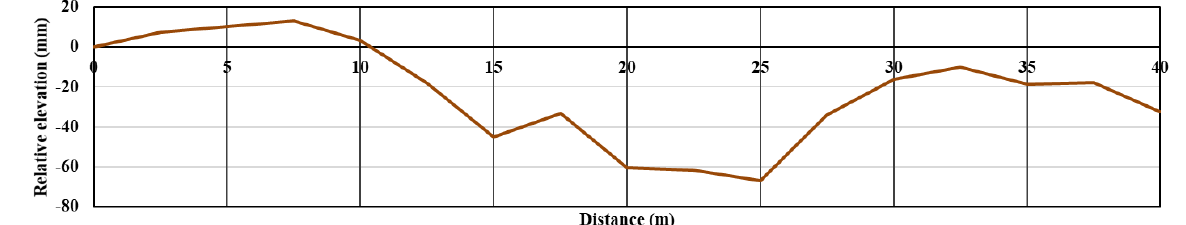
Figure 7. The relative elevation inside the sewer pipe. Figure 6. The relative elevation inside the sewer pipe. Figure 6. The relative elevation inside the sewer pipe.